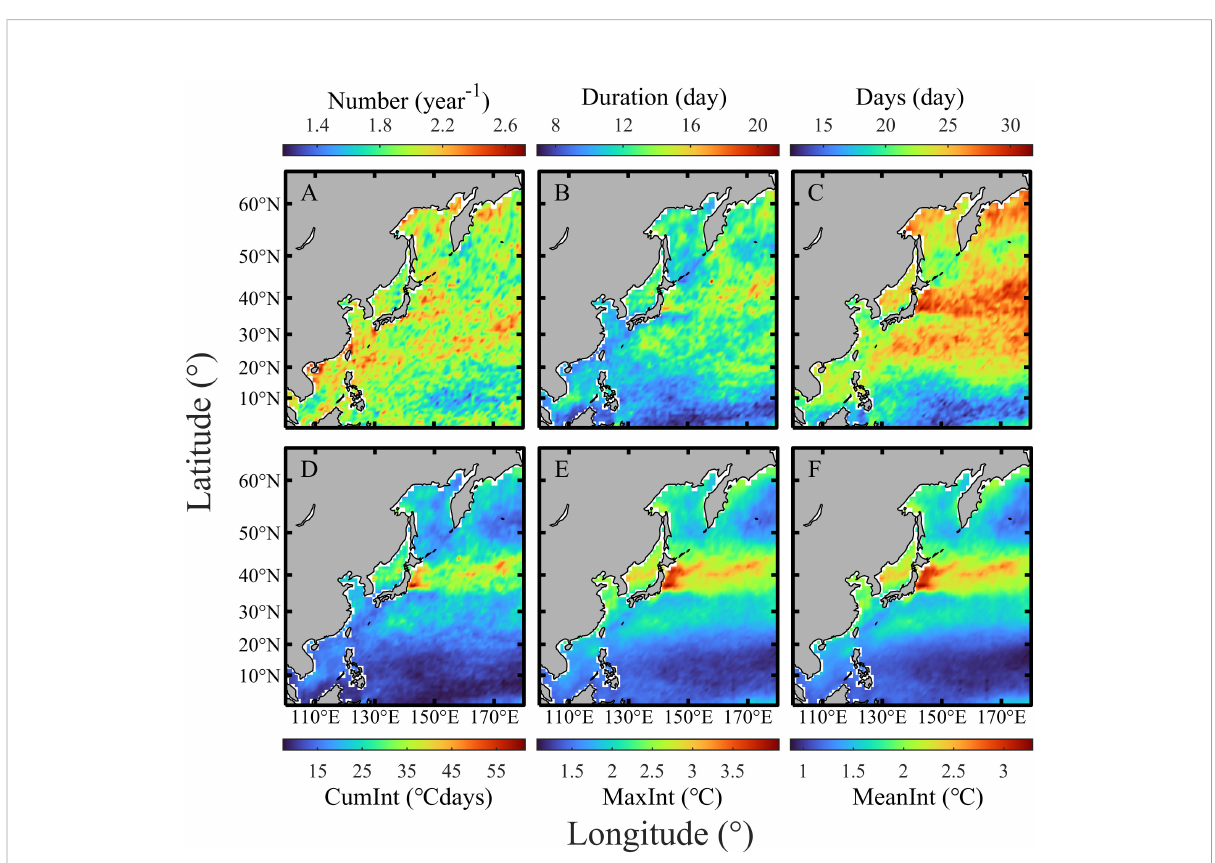
FIGURE 4 Spatial distribution of multi-year averages historical MHWs characteristics in the WNPCC area based on OISSTV2 data. Multi-year averages MHWs (A) Number (units: year -1 ), (B) Duration (units: day), (C) Days (units: day), (D) CumInt (units: °C days), (E) MaxInt (units: °C), and (F) MeanInt (units: